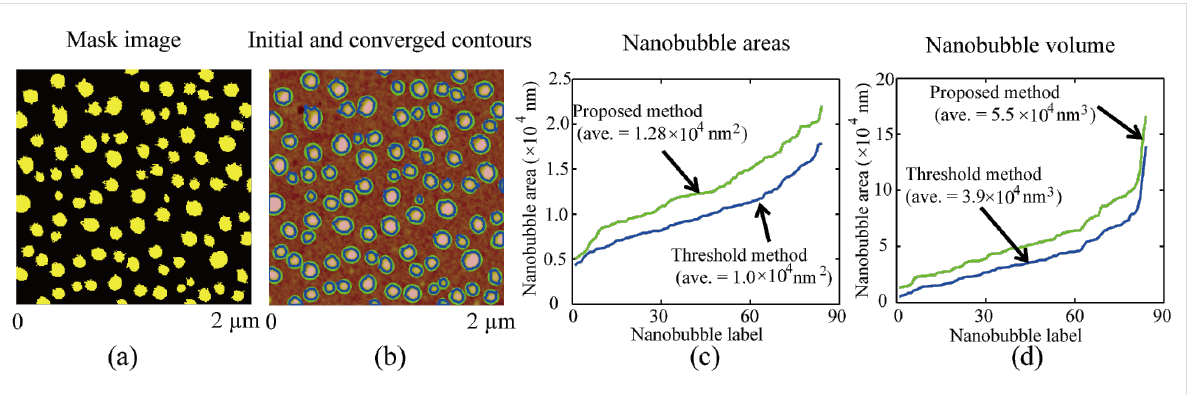
Figure 8: Implementation of image segmentation for all NBs in an AFM image. (a) Mask image obtained using the threshold method. The boundaries of the mask areas were taken as the initial guesses for boundary detection. (b) Initial contours (blue) and converged contours (green) for individual NBs. (c,d) Comparison of covered areas and volumes detected with the threshold method and the proposed method. One can see that both the covered areas and volumes detected with the threshold method are underestimated compared with that obtained by the proposed method.